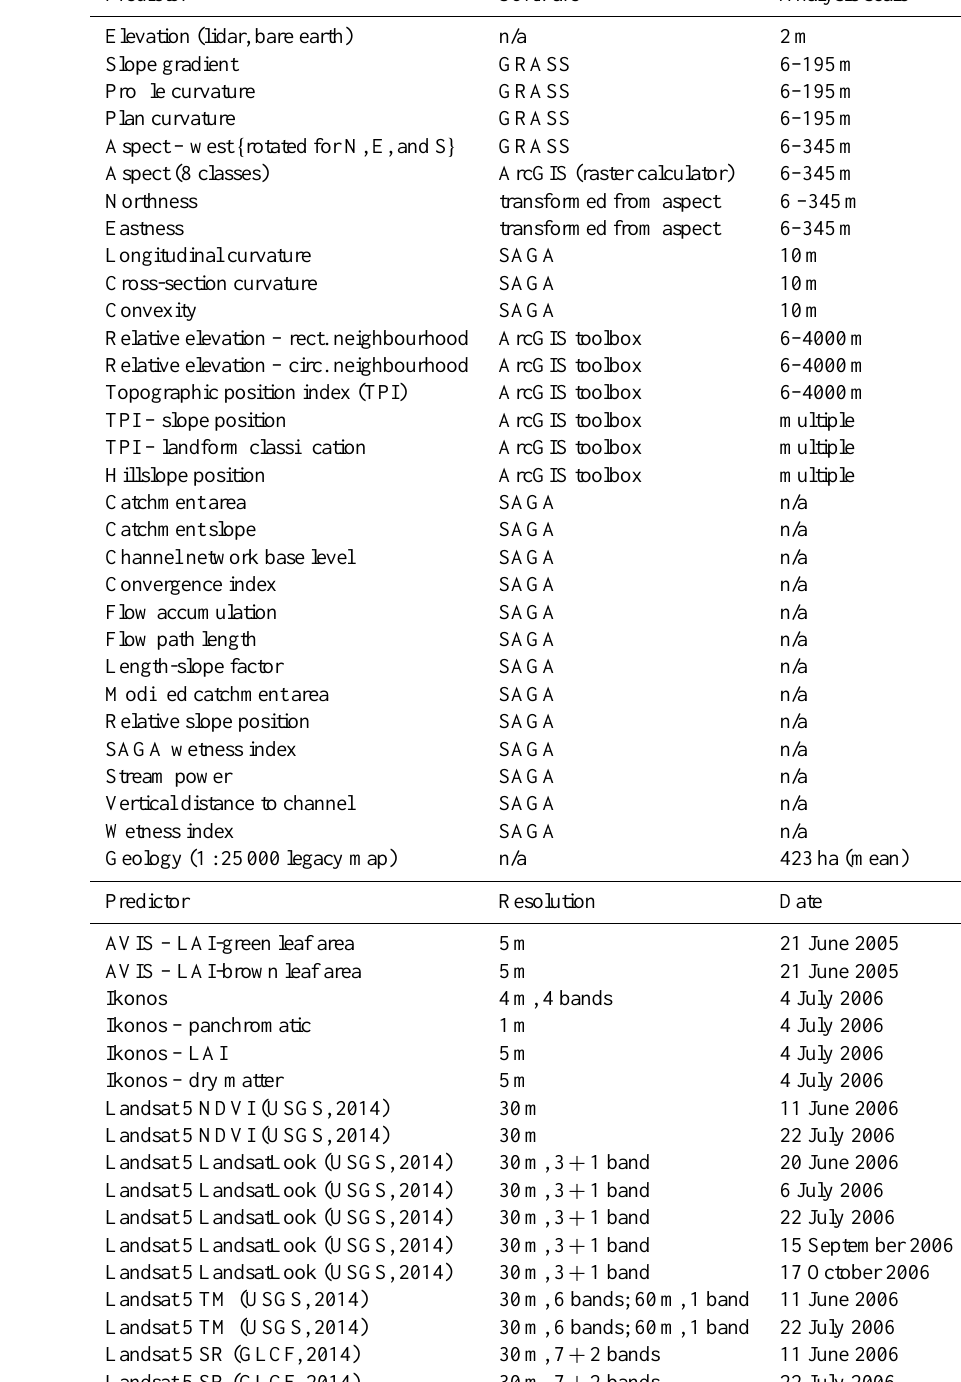
Table 2. Predictor variables considered in this